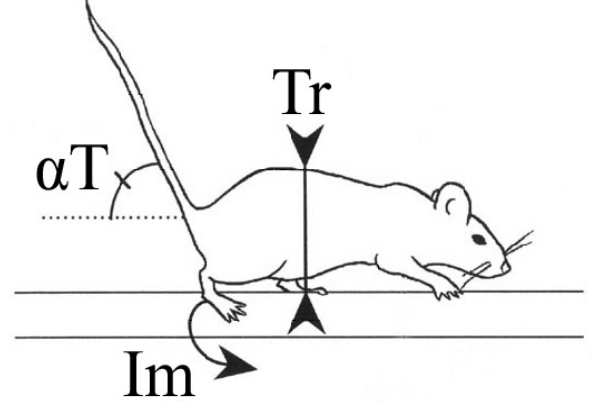
FIGURE 4. Assessment of performance on a rotating beam . Performance was assessed by the number of falls, the number of imbalances (Im), the angle of the tail ( α T), and the elevation of the trunk (Tr). (Adapted from Lepicard et